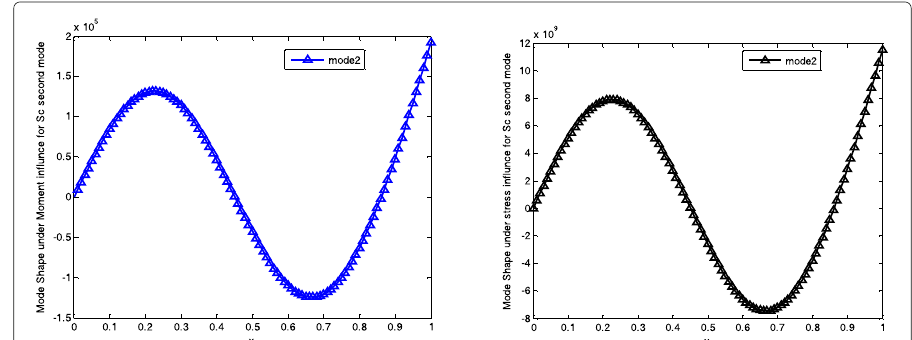
the vibrating plate changes. While Fig. 6 depicts the extrema mode shape variation. It is clearly revealed that Figs. 5 and 6 when compared to Fig. 4 have different mode